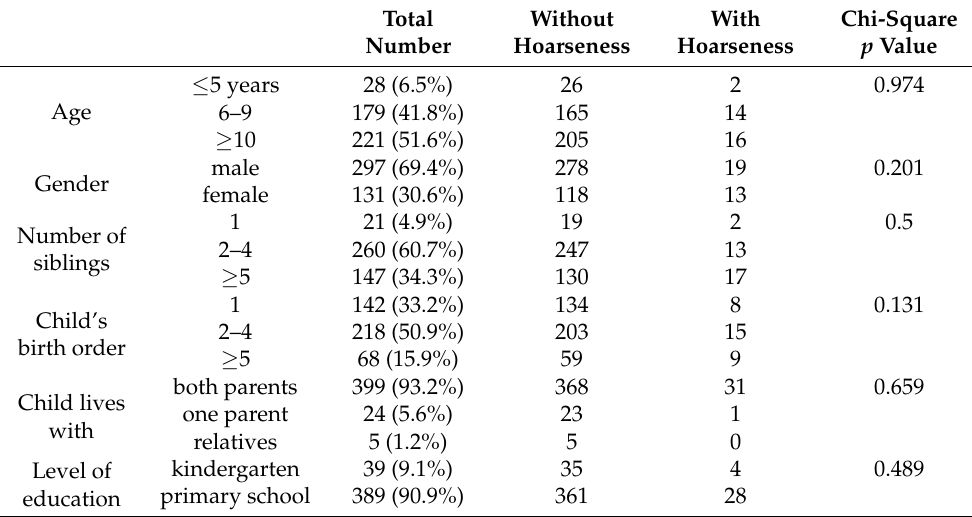
Table 1. Distribution of participants’ sociodemographic data ( n =